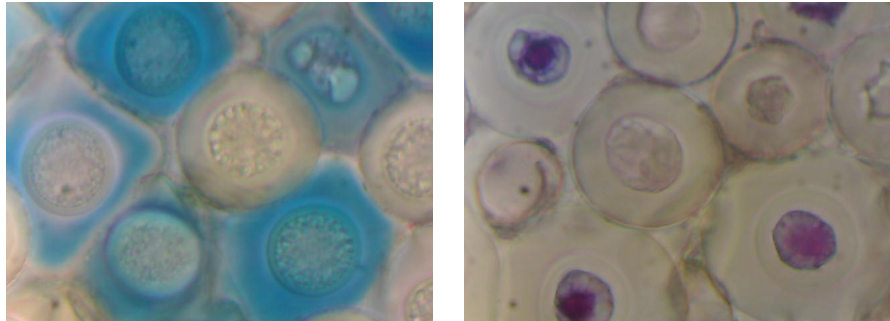
Figure 2. Cupressus pollen stained with Trypan blue ( left ) and Pyrogallol red ( right ). Statistical Analysis. To determine differences between treatments and stress condi- tions, non-parametric Spearman’s correlation analyzes were performed, since the data do not fit a normal distribution. Finally, to determine statistical differences between the control treatments and the samples, an analysis of variance (ANDEVA) and a Tukey HSD test (95%) were performed a posteriori. These methods aim to compare the individual means from an analysis of variance of several samples subjected to different treatments, this test allows discerning whether the results obtained are significantly different or not. To perform the statistical analyzes, the IBM SPSS Statistics software was